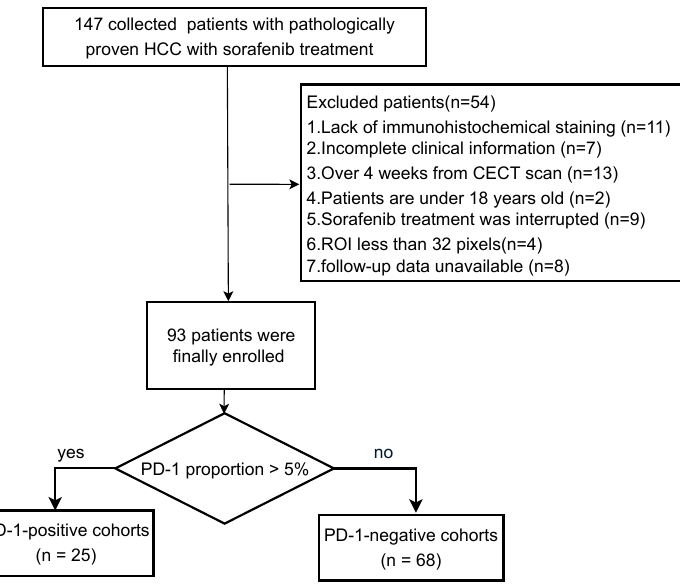
Figure 1. Patient recruitment